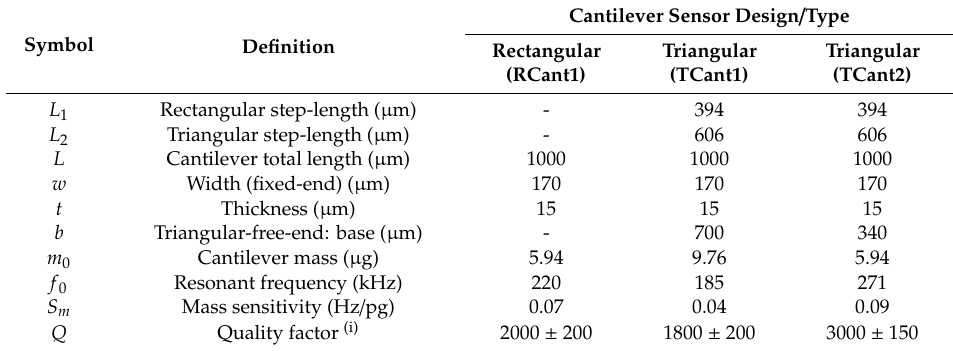
Table 1. Cantilevers design parameters and simulated characteristics.